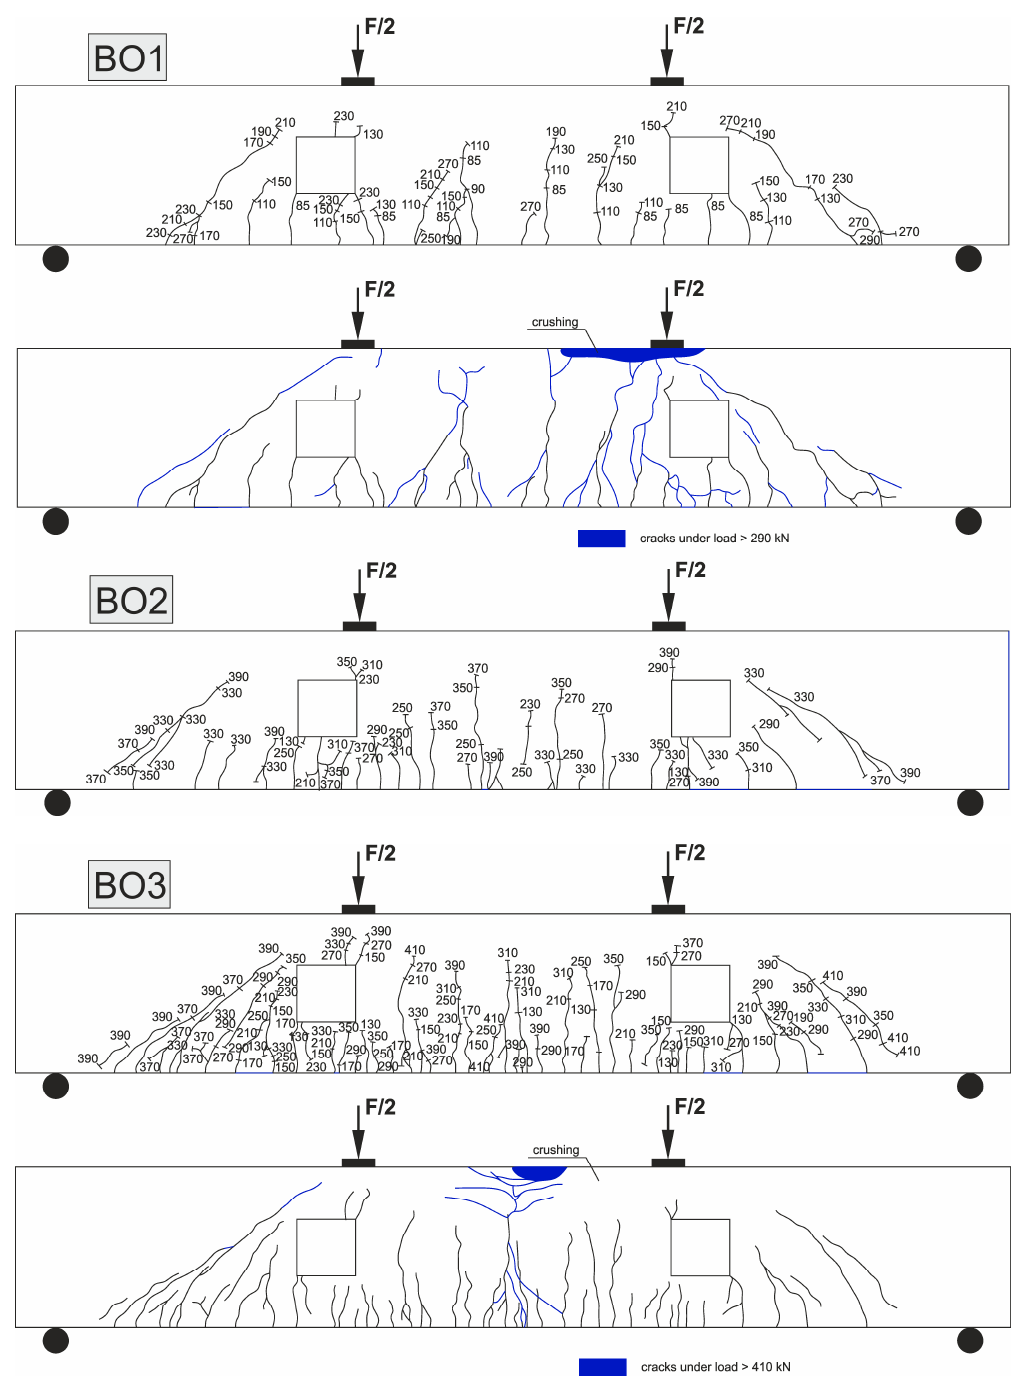
Figure 6. Crack patterns for beams.